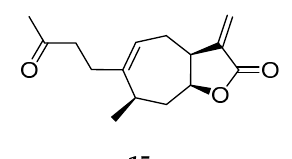
Figure 11. Structure of tomentosin ( 15 ).